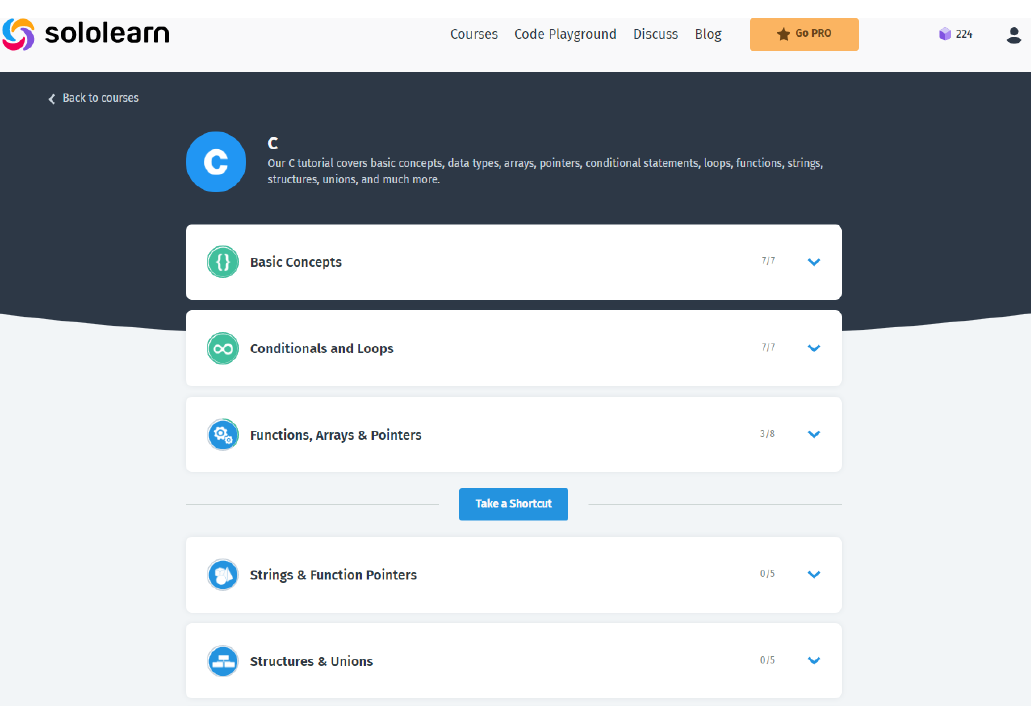
Figure 1: Personal account for studying the